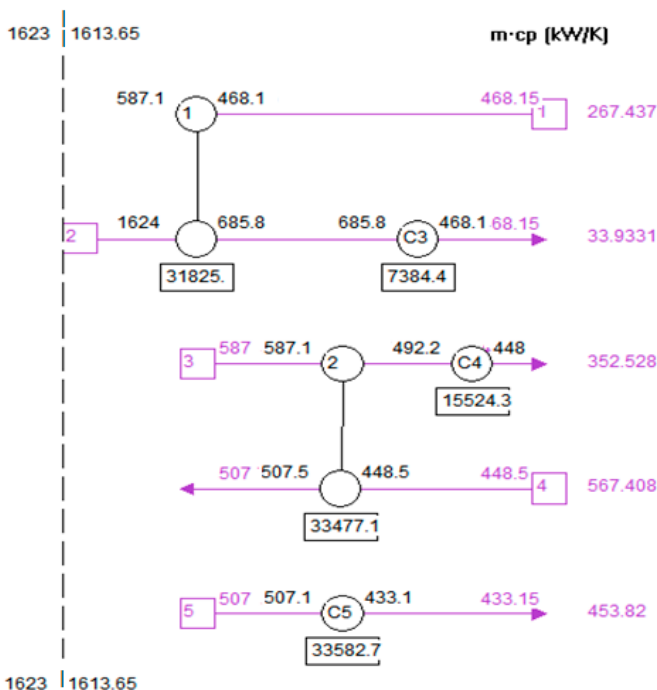
Figure 8. Heat exchanger network (HEN) design of heat exchanger.